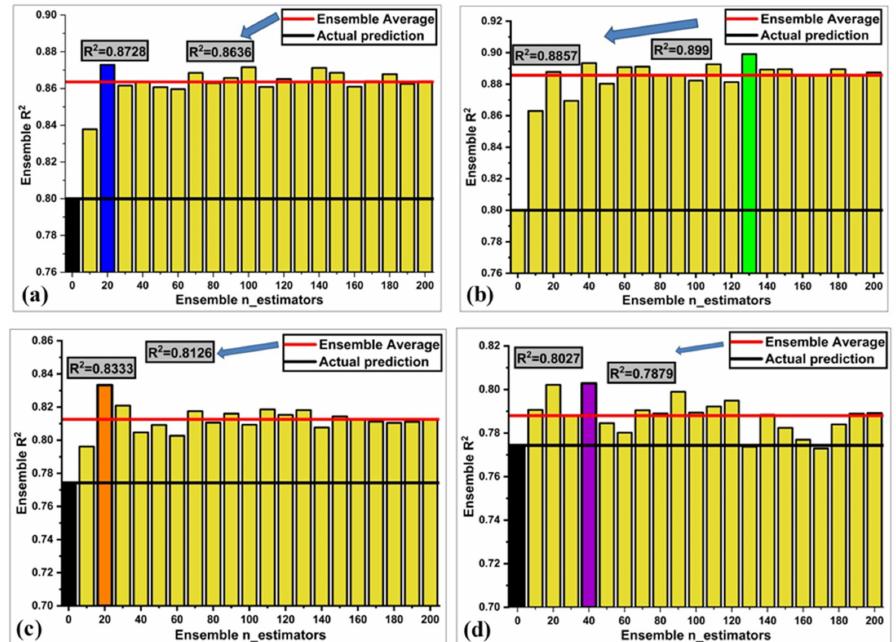
Figure 7. Results of ensemble ML models with their sub-models. ( a ) DT-Bagging; ( b ) DT-Adaboost; ( c ) MLPNN-Bagging; ( d ) MLPNN-Boosting.